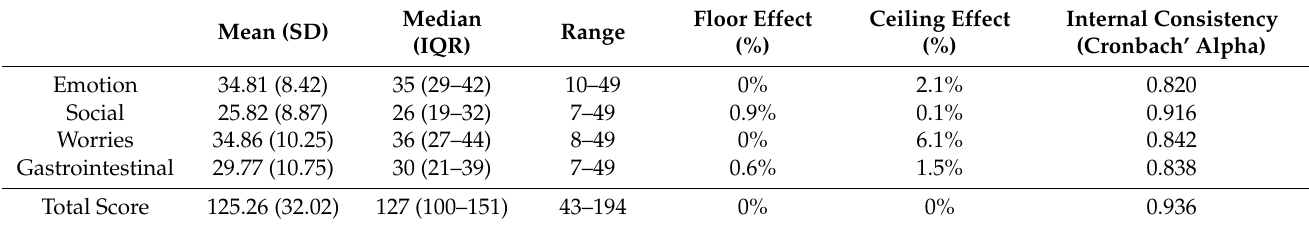
Table 1. Analysis of the precision of the subscales ( n = 674) of the CDQ